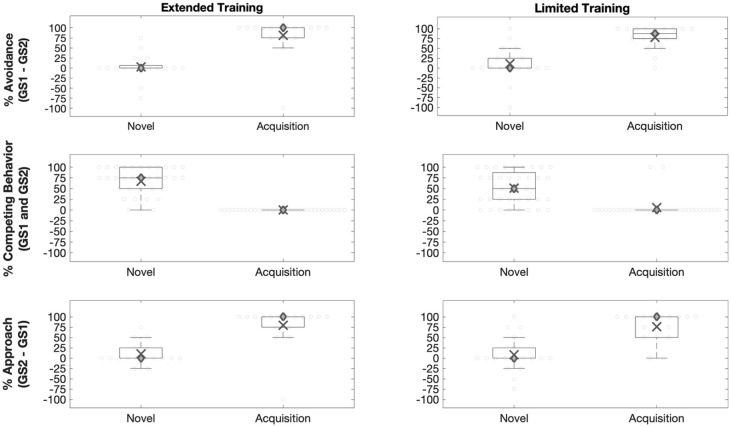
Outcome measures: Generalised avoidance. Generalised avoidance was estimated as responding to GS1 relative to GS2. A positive score indicates more avoidance of GS1. A negative score indicates more avoidance of GS2. Relative avoidance of GS1 was greater in the Acquisition context than in the Novel context. This was evident in both training groups. Competing behaviours. There was no effect of stimulus on competing behaviour. Overall, competing behaviours were more frequent in the Novel context than in the Acquisition context. Generalised approach. Generalised approach was estimated as responding to GS2 relative to GS1. A positive score indicates more approach of GS2. A negative score indicates more approach of GS1. Relative approach of GS2 was greater in the Acquisition context than in the Novel context. This was evident in both groups. ○ = Individual data points; X = mean; ◊ = median. Edges of the box are the 25th and 75th percentiles. Whiskers extend to extreme value not considered to be an outlier.